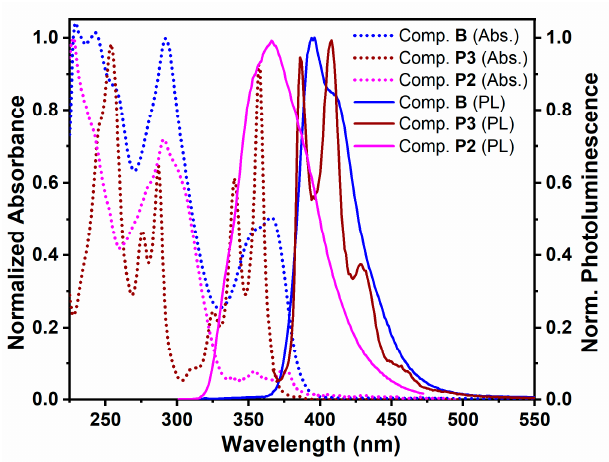
Figure 4. Normalized UV-vis absorption (Abs.) and photoluminescence (PL) spectra of compound B and its synthetic precursors: pyrene derivative ( P3 ) and benzimidazole derivative ( P2 ) in DCM.